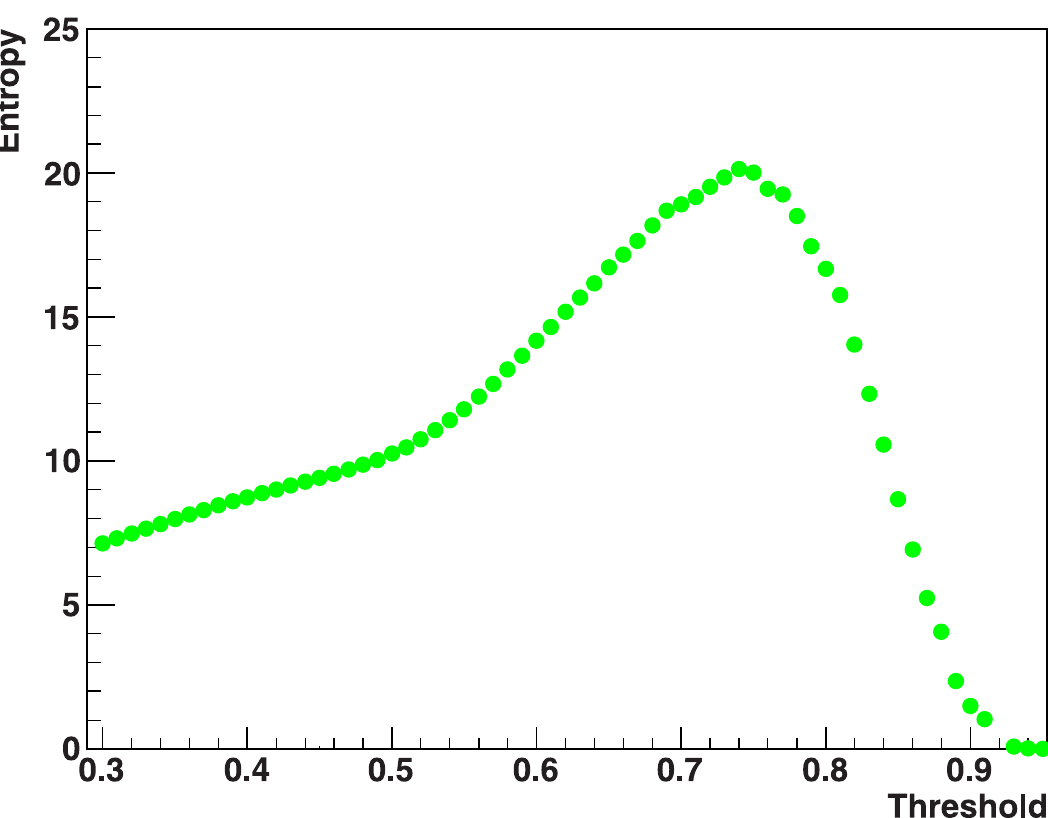
Fig 5. Betweenness entropy as a function of threshold. Information entropy distribution based on betweenness as a function of threshold for the whole network. The distribution presents a maximum at a threshold value equal to 0.74.